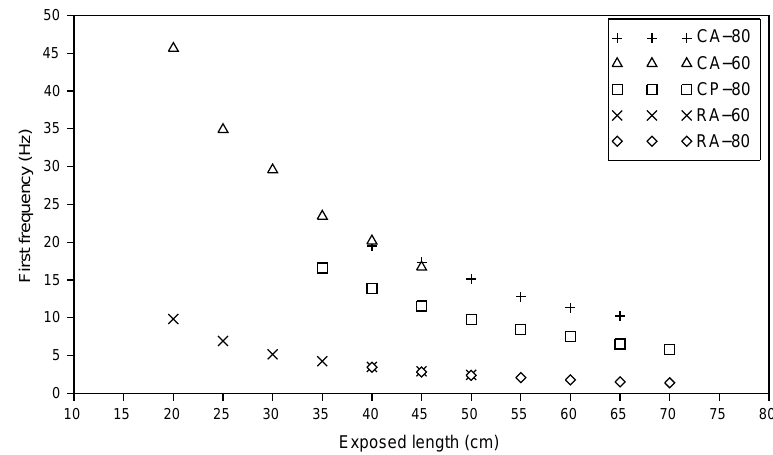
Figure 5. Variation of first frequency with exposed length in sandy soil.